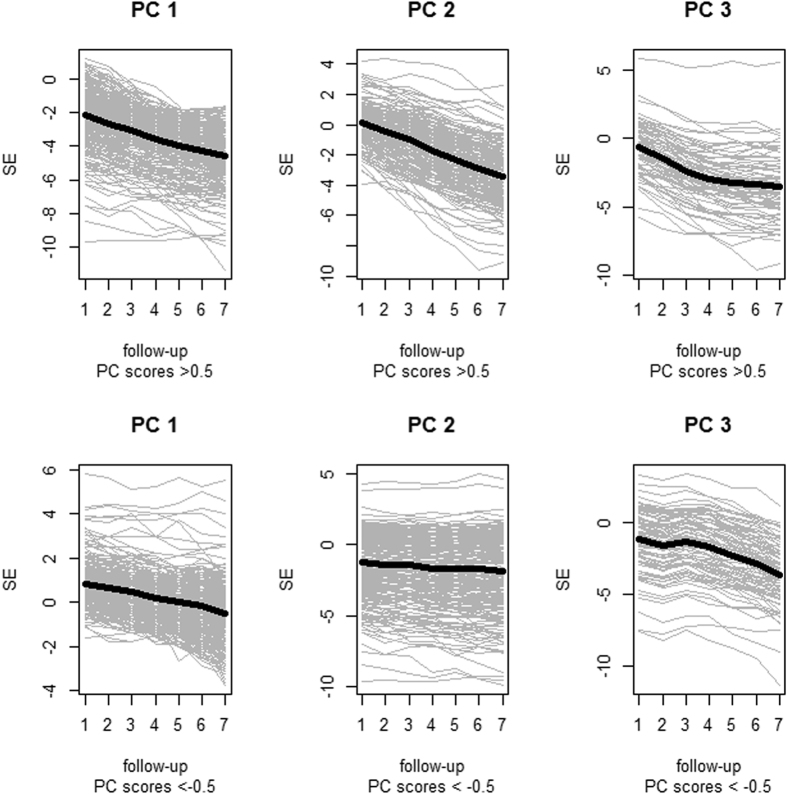
The patterns of different principle component scores in refraction progression (PC: principle component; SE: spherical equivalent).